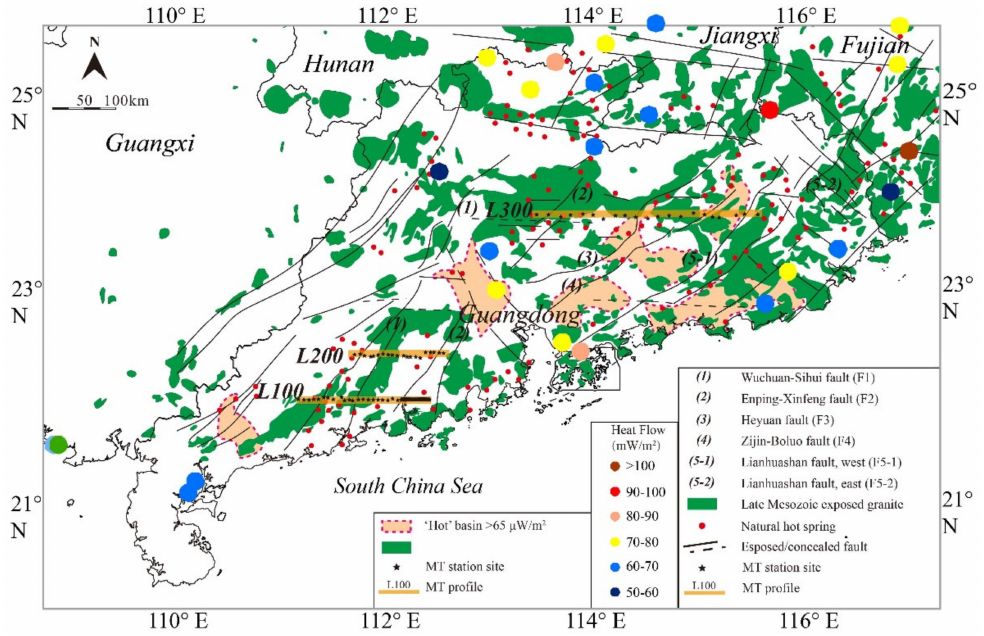
Figure 2. Tectonic map of Guangdong Province and adjacent area. The distribution of faults is modified from Wang et al. [6]. The yellow lines are the magnetotellurics profiles. The heat flow values and “hot” basin are modified from Jiang et al.